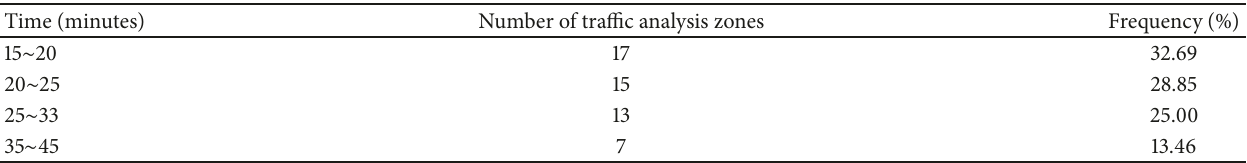
Figure 4: Spatial accessibility distribution of public transportation in Chenggong New District. Table 3: Distribution frequency of time accessibility in traffic analysis